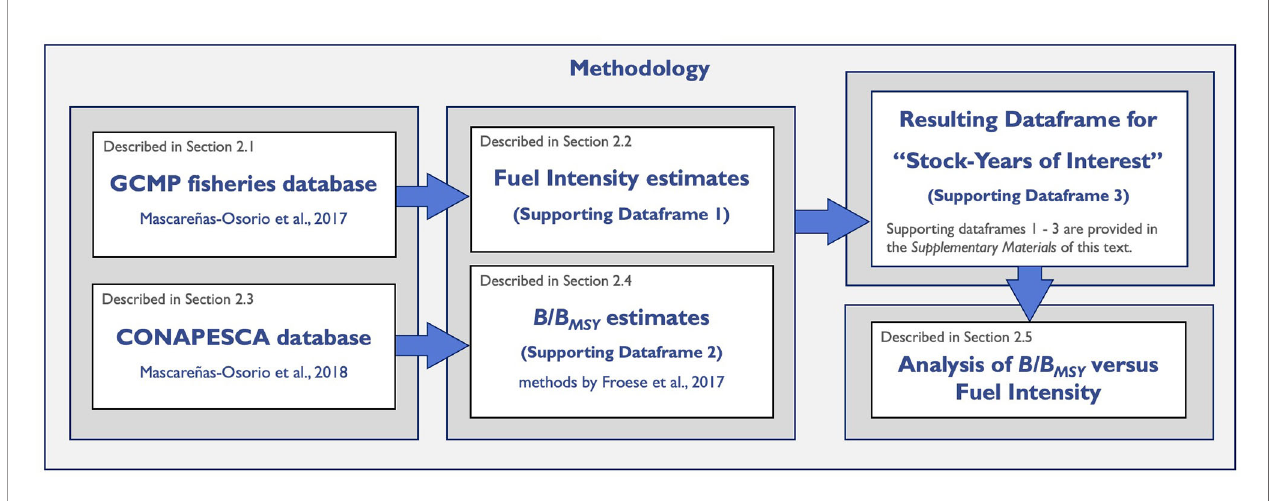
FIGURE 1 | Infographic showing our methodological fl ow from Section 2.1 to 2.5. Here, “ GCMP ” stands for the Gulf of California Marine Program, and “ CONAPESCA ” stands for the Comisio ́ n Nacional de Acuacultura y Pesca